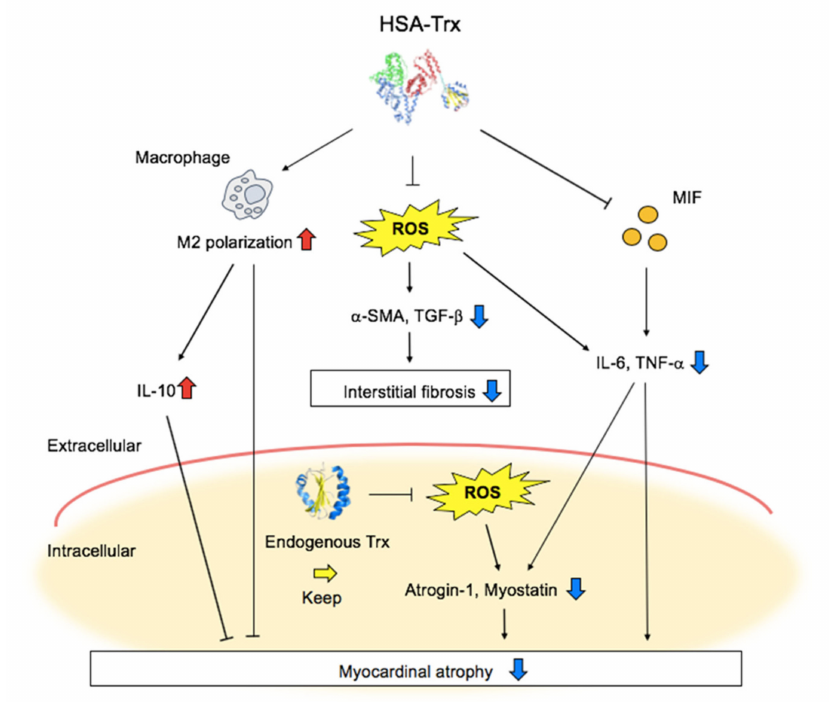
Figure 5. Schematic diagram showing the effect of HSA-Trx on Dox-induced myocardial atrophy. Supplementary Materials: The following are available online at https://www.mdpi.com/article/ 10.3390/pharmaceutics14030562/s1, Figure S1: Dox-induced cardiomyopathy model mice by the intraperitoneal injection of Dox; Figure S2: The effect of HSA-Trx on body weight decrease in Dox- induced cardiomyopathy model mice; Figure S3: Complete Western blot images before cropping into result Figure 2; Table S1: The primers used for mRNA